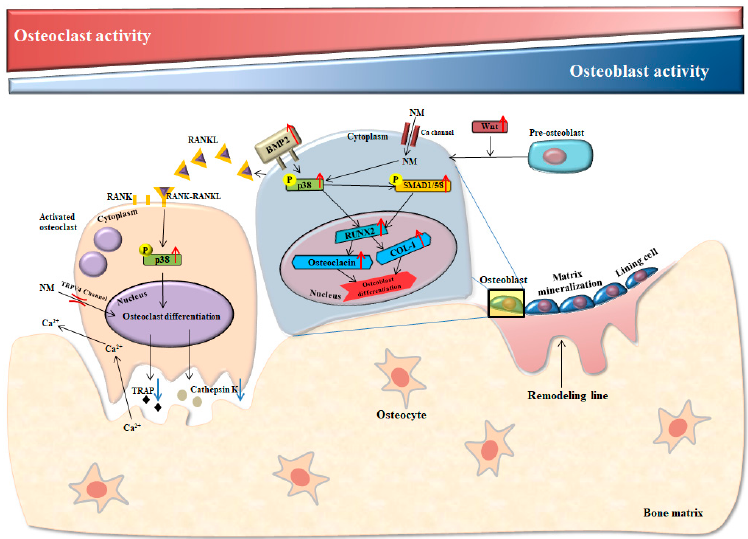
Figure 8. E ff ect of nano-montmorillonite on osteoblastogenesis and